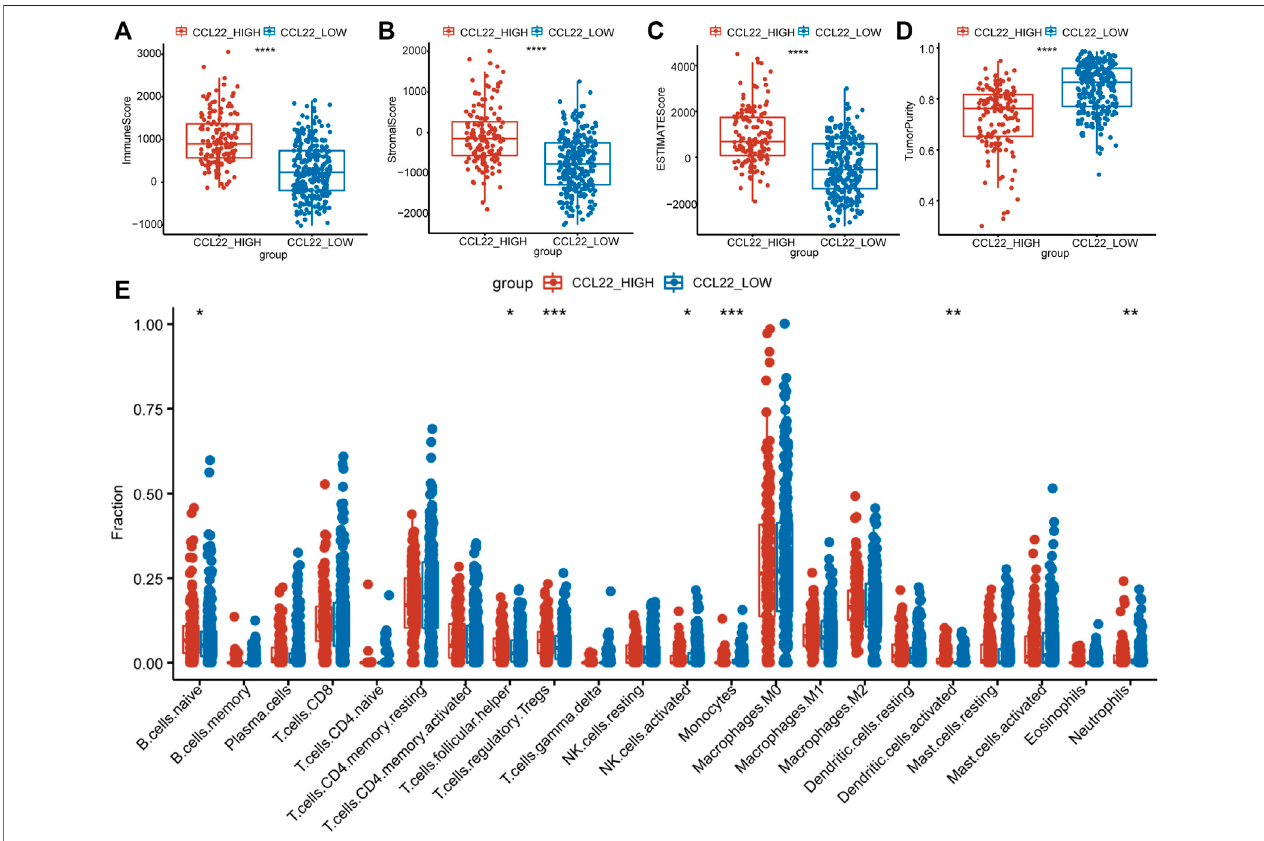
FIGURE 5 | Tumor microenvironment changes associated with CCL22 in The Cancer Genome Atlas colon adenocarcinoma. (A) The immune score, (B) stromal score, (C) estimated score, and (D) tumor purity and (E) the proportion of 22 types of in fi ltrating immune cells in high- and low-CCL22-expression subgroups.